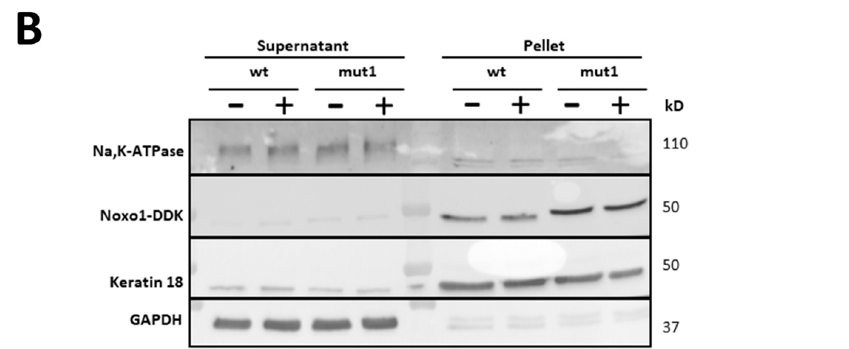
Figure 11. Immunofluorescence Noxo1 with keratin 18 in Caco-2 transfected with wt Noxo1- or mut1 Noxo1-DDK. ( A ) Immunofluorescence wt Noxo1-DDK (left upper panel, green) and keratin 18 (middle upper panel, red). Keratin 18 organization in cells transfected with wt Noxo1-DDK or mut1 Noxo1-DDK assessed with an antibody directed against keratin 18 (red). The overlay upper right panel corresponds to wt Noxo1-DDK/keratin. Immunofluorescence mut1 Noxo1-DDK (left lower panel, green), and keratin 18 (middle lower panel, red). The overlay (right lower panel) cor- responds to mut1 Noxo1-DDK/keratin 18. There is a clear colocalization of Noxo1 with keratin 18 at many spots or sites for either the wt or mut1 form of Noxo1 (yellow). Scale bar in all panels: 25 µm.